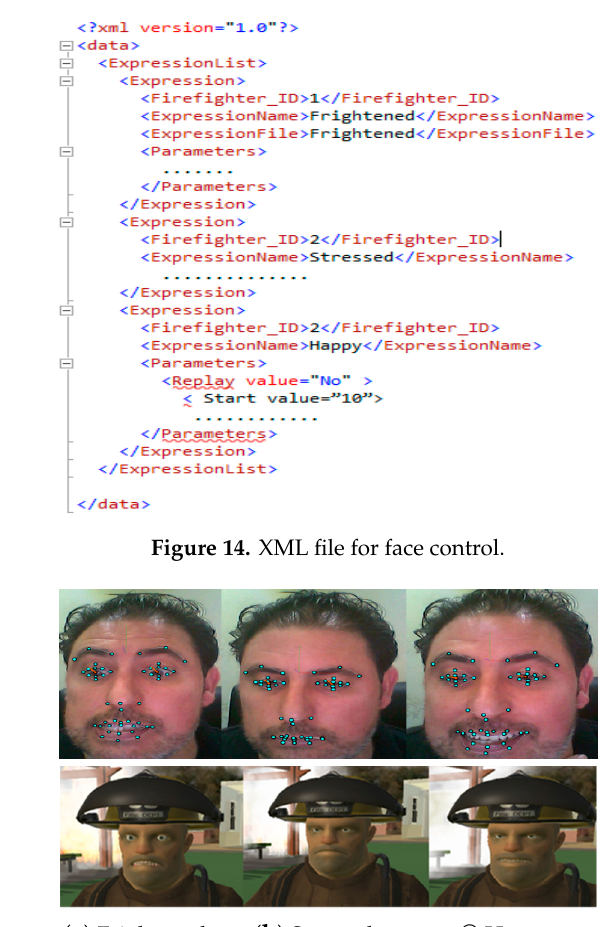
Figure 15. Facial animation samples and corresponding MPEG-4 validation.